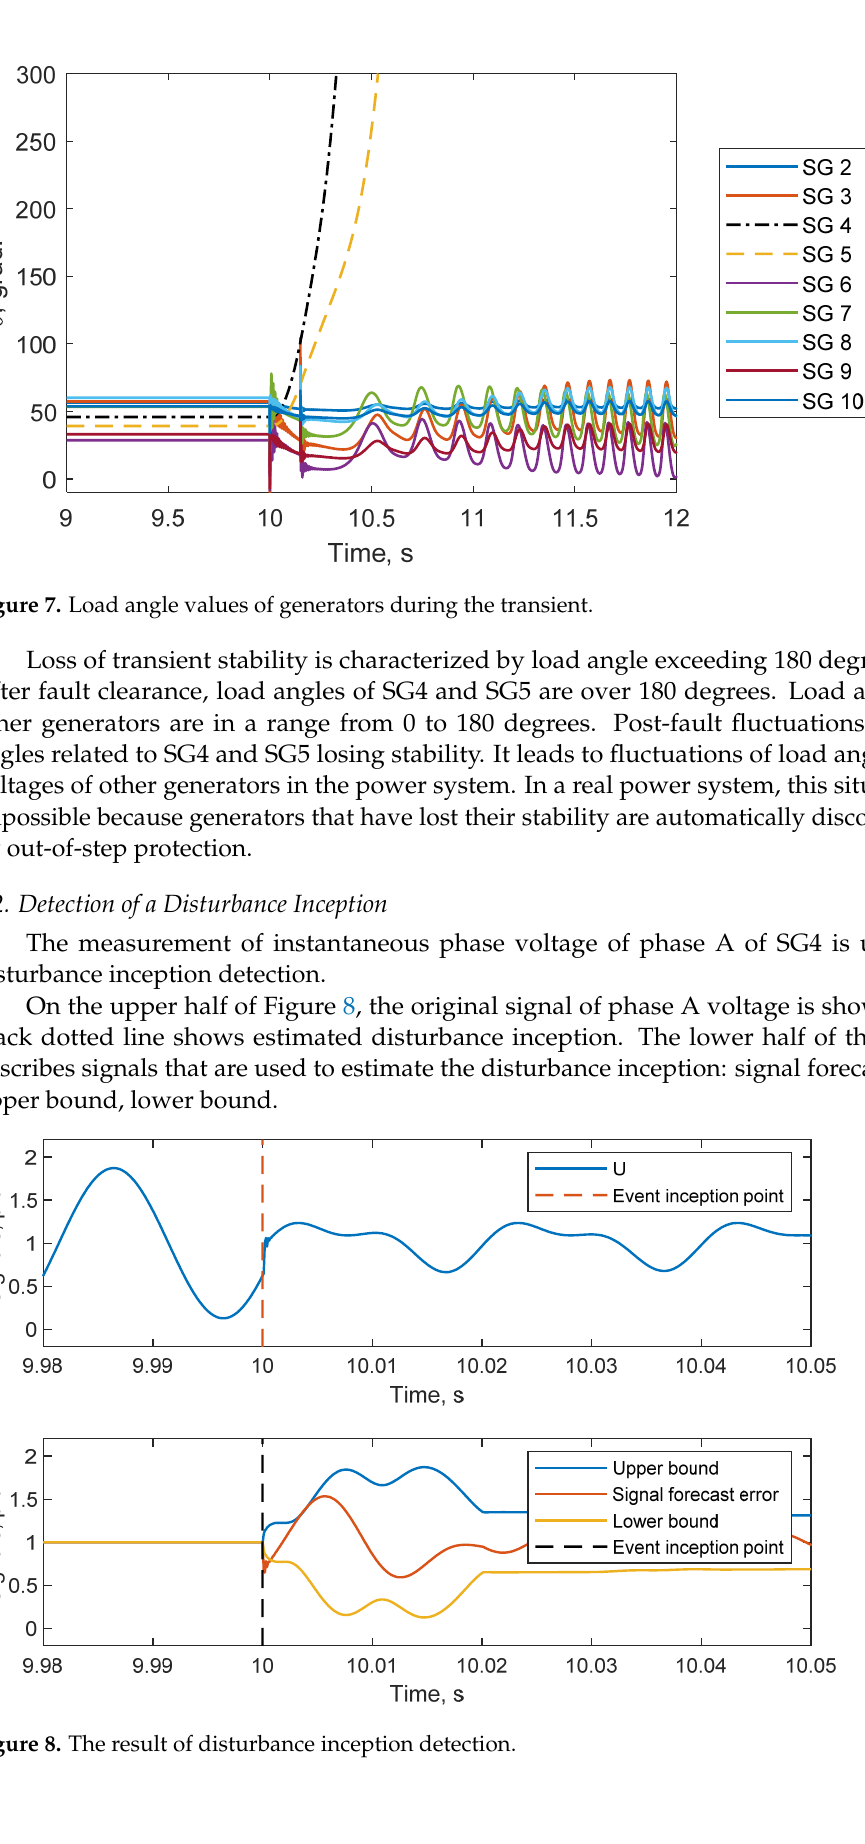
Figure 9. Influence of the algorithm parameters on the error of disturbance inception detection. The legend of Figure 9 shows considered forecasting windows. Beginning from the training window size of 5 ms and forecasting window of 0.6 ms the value of disturbance inception detection error is stabilized at a level of 0.2%. The suggested algorithm allows detecting times of fault inception and clearance. 4.3. Estimation of Generator Transient Stability and TFV Control Synthesis The results of estimating the excess rotor and turbine acceleration are given in Table 3. In addition, Table 3 shows potential deceleration energy, damping energy, and unbal ‐ anced energy. A positive value of unbalanced energy indicates loss of stability of SG4 and SG5 after disturbance. High values of SG5 unbalanced energy indicate that the SG5 derivative of rotor velocity is higher than that of SG4, which is proven by the results of the transient simulation.